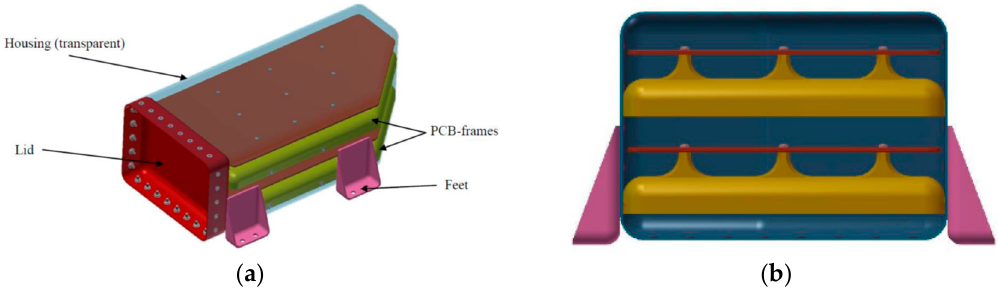
Figure 14. ( a ) Breadboard assembly, result of the preliminary design ( b ) Front view of the breadboard (without the lid) with detail of the CFRP-based PCB (printed circuit board)-frames.